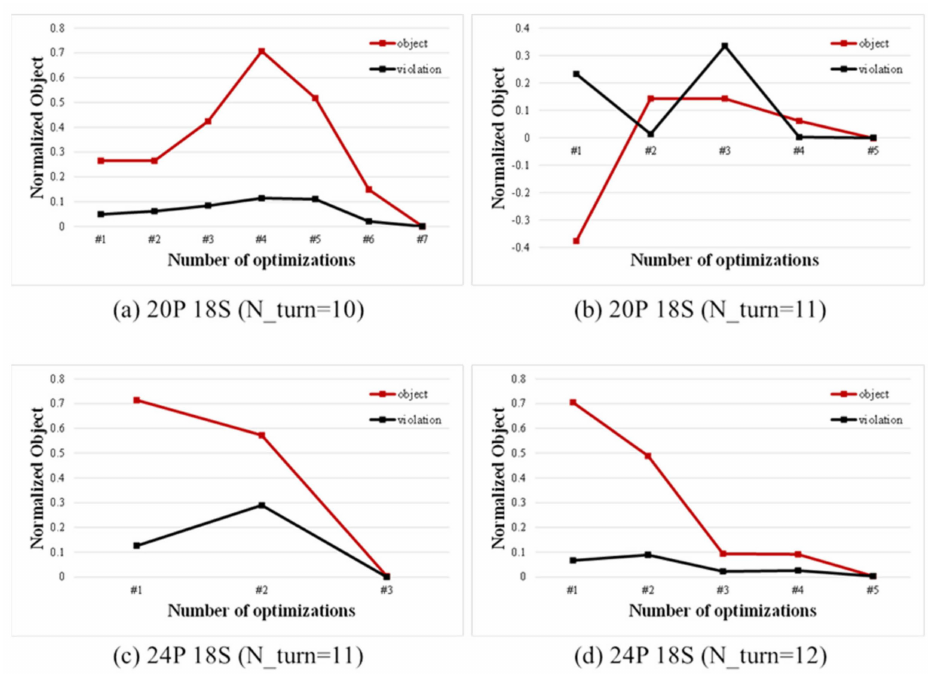
Figure 19. Convergence history.